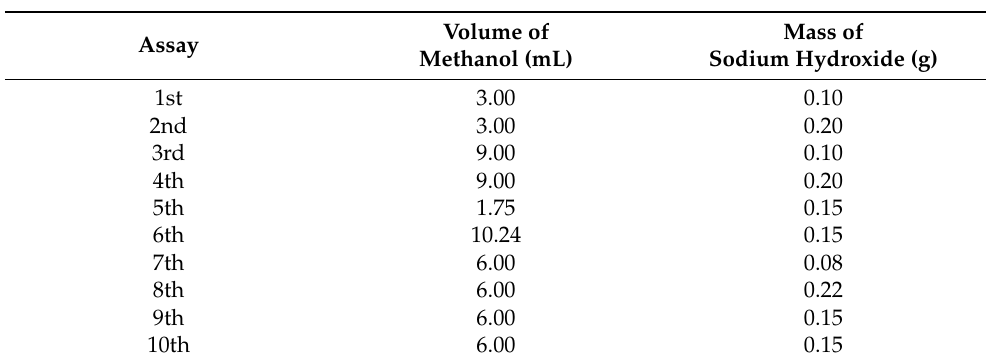
Table 2. Laboratory planning